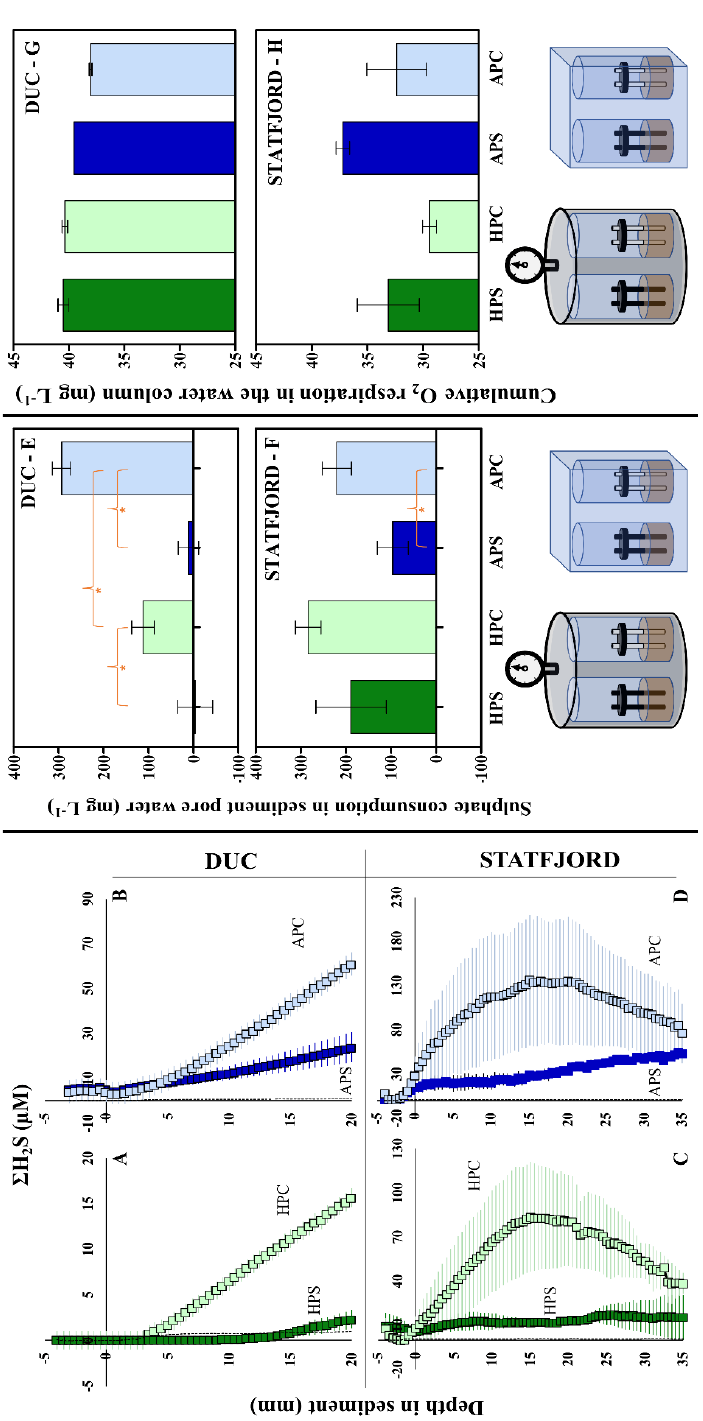
Figure 2. Microprofiles of total hydrogen sulf ide (ΣH 2 S = [H 2 S] + [HS − ] + [S 2 − ]) concentrations ( A – D ), sulfate (SO 42 − ) in sediment pore water ( E , F ) and cumulative O 2 respiration in seawater overlying contaminated sediments at the end of 7 weeks of incubation in sediments contaminated with either Duc ( A , B , E , G ) or Statfjord ( C , D , F , H ) oil (n = 3; bars represent standard errors). Microprofiles of ΣH 2 S at time zero ( A – D ) are indicated as dotted lines. Initial SO 42 − concentrations ( E , F ) are indicated as horizontal dotted lines, with the grey areas representing the standard error (n = 3). The cumulative amount of O 2 in seawater provided through the 7 weeks of incubation was ~55 mg L − 1 . Abbreviations reported in the graph: HPS, high pressure with snorkels; HPC, high pressure with glass controls; APS, ambient pressure with snorkels; APC, ambient pressure with glass controls. Asterisks indicate statistically significant difference between the bars located at the two extremes of the